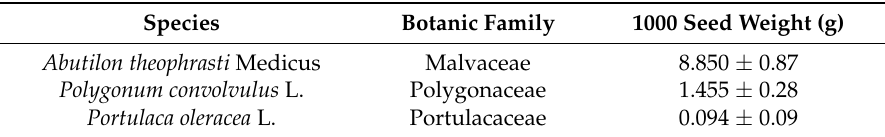
Table 2. Seed weights of the three studied